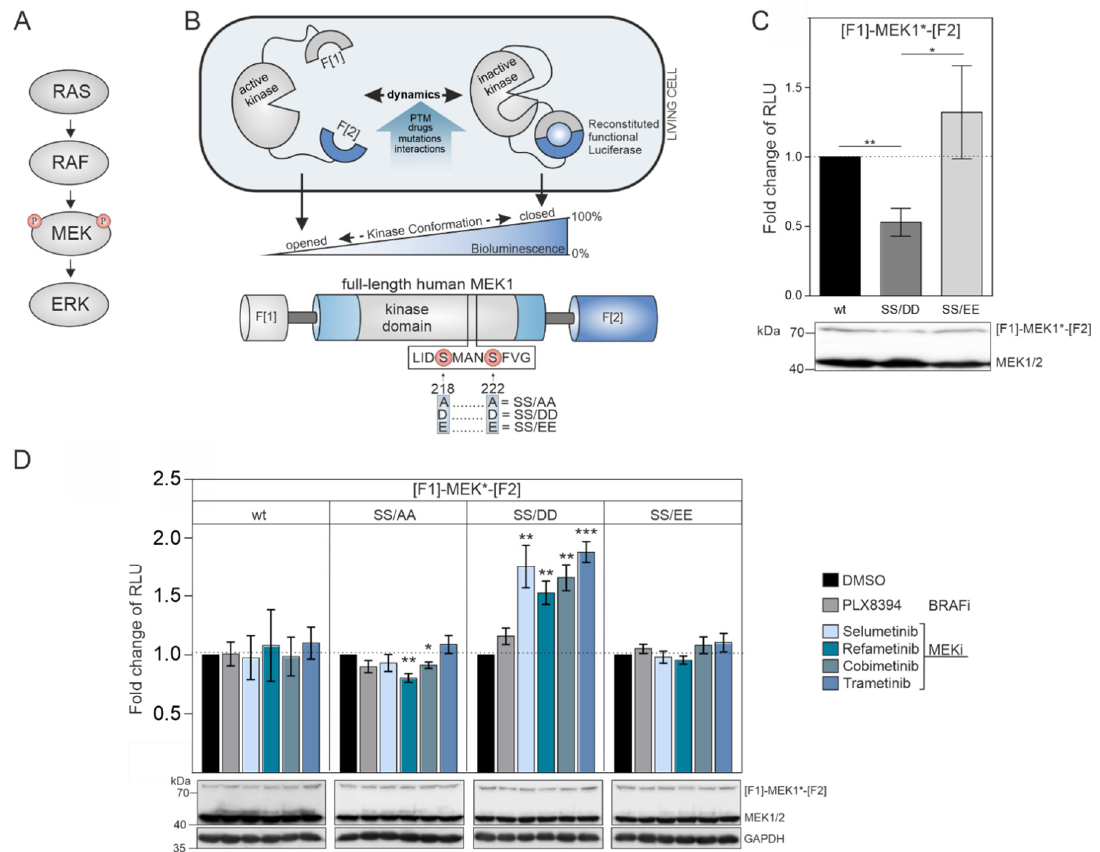
Figure 1. MEK1 KinCon reporter dynamics: ( A ) Simplified illustration of RAS-activated signal transmission within the RAS–RAF–MEK signaling pathway. ( B ) Schematic depiction of the MEK1 KinCon reporter principle indicating fragments 1 and 2 (= F[1]/F[2]) of the R luc-based PCA (top). Post-translational modifications (PTM), small-molecule binding, kinase domain mutations or protein–protein interactions may convert the MEK1 KinCon reporter into different kinase conformation states which are displayed by alterations of PCA-emitted bioluminescence signals. Domain organization of the MEK1 KinCon reporter iis shown. Activating phosphorylation sites are indicated. Their respective mutations to alanine (SS/AA), aspartic acid (SS/DD) and glutamic acid (SS/EE) are highlighted. ( C ) Effect of the phospho-mimetic site mutations S218D/S222D and S218E/S222E on MEK1 KinCon dynamics. Bars represent obtained bioluminescence signals in relative light units (RLU) relative to the signals of the wild-type MEK1 KinCon (± SEM from n = 6 independent experiments; normalized on KinCon reporter expression levels, (HEK293T)). ( D ) Dynamics of indicated MEK1 KinCon reporter signals upon exposure to four MEKi (1 µM), the RAFi PLX8394 (1 µM) or DMSO for 1 h. Bars represent the fold change of RLU relative to the DMSO control of the respective reporter entity (± SEM from at least n = 6 independent experiments, HEK293T). Student’s t -test was used to evaluate statistical significance. Confidence level is indicated by asterisk as: * p < 0.05, ** p < 0.01, *** p < 0.001.